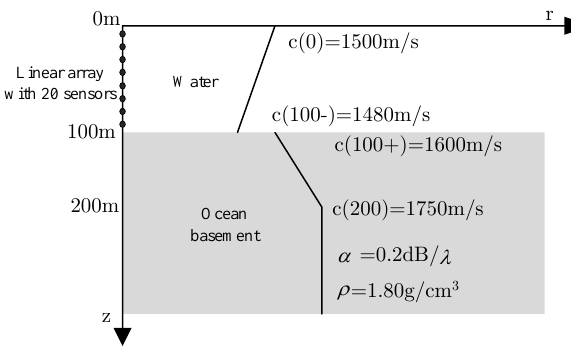
Figure 4. GENLMIS environment model with mismatch.